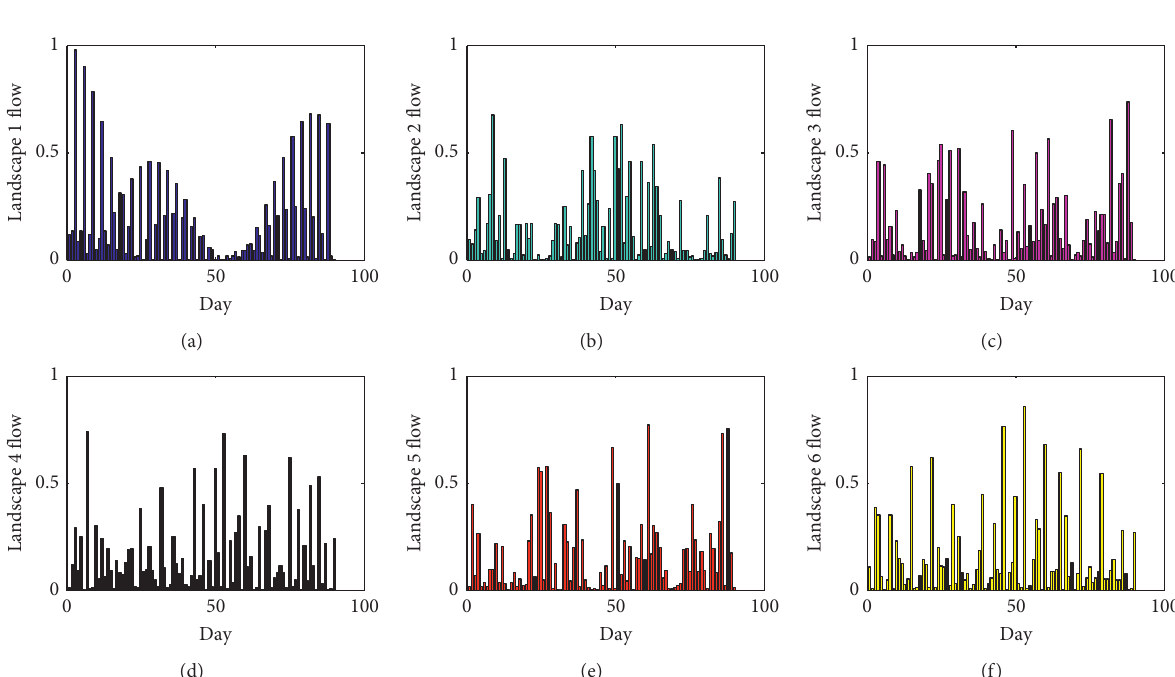
Figure 6: The data query and test of historical flow data of 6 landscape